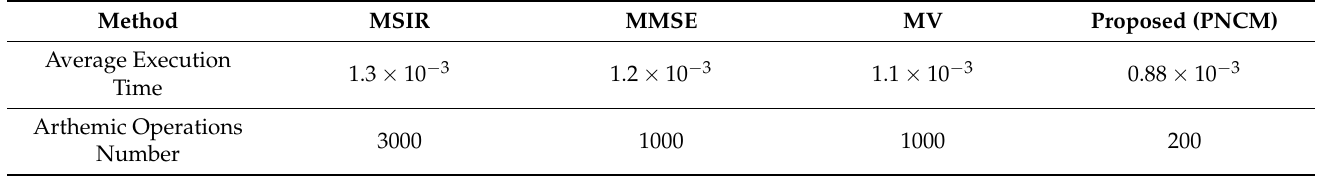
Table 6. Execution time comparison between the proposed beamforming and three different